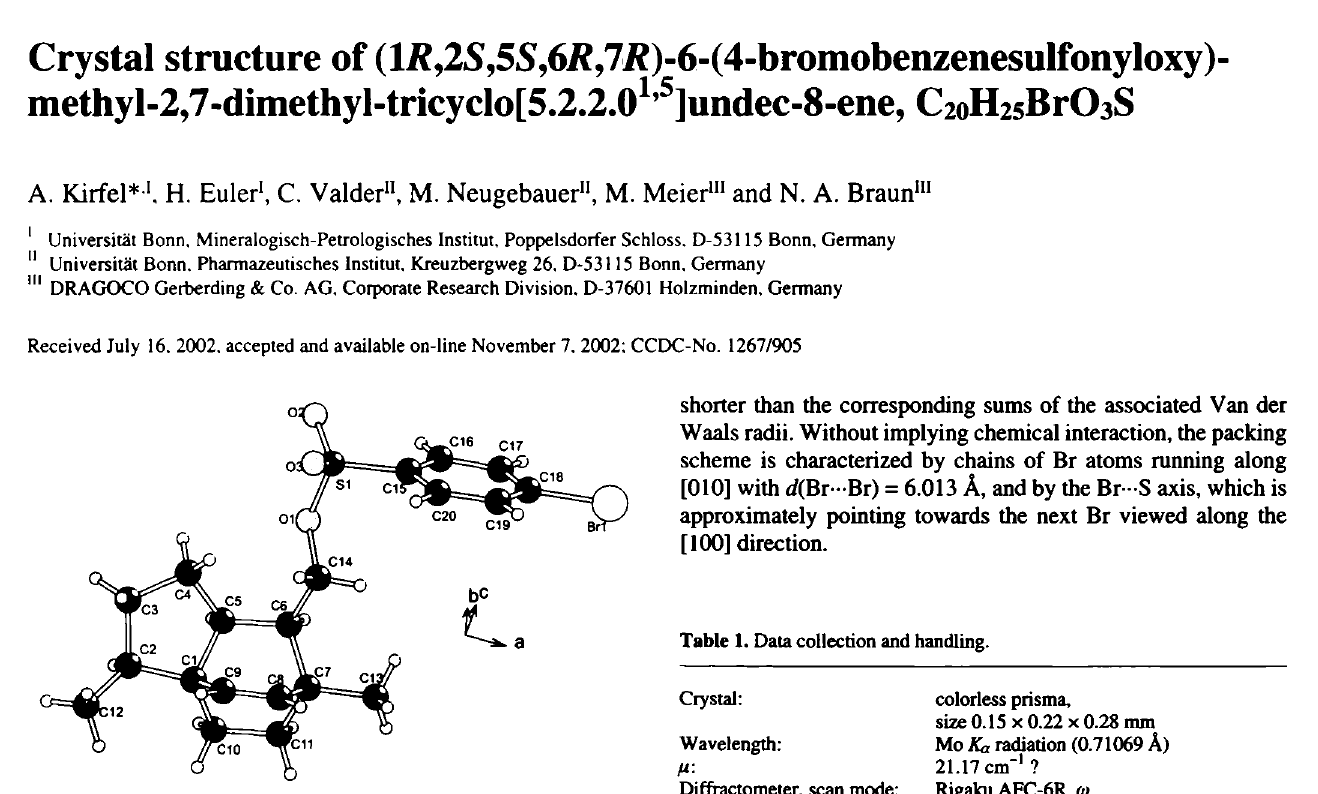
Table 2. Atomic coordinates and displacement parameters (in Â 2